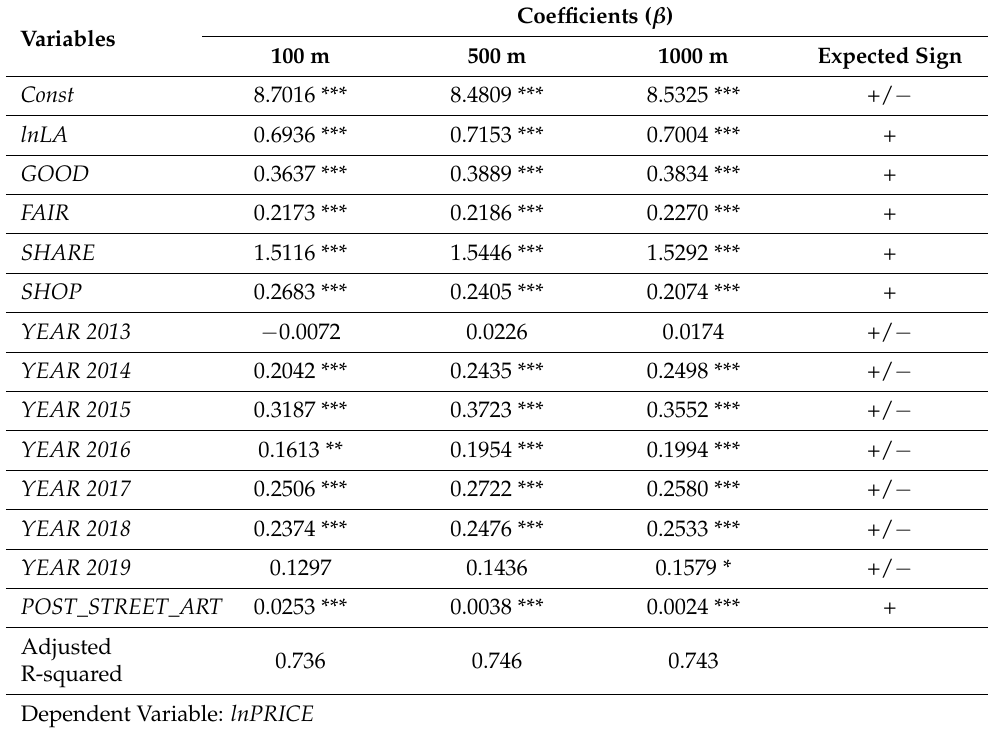
Table 8. OLS Regression Results of Model